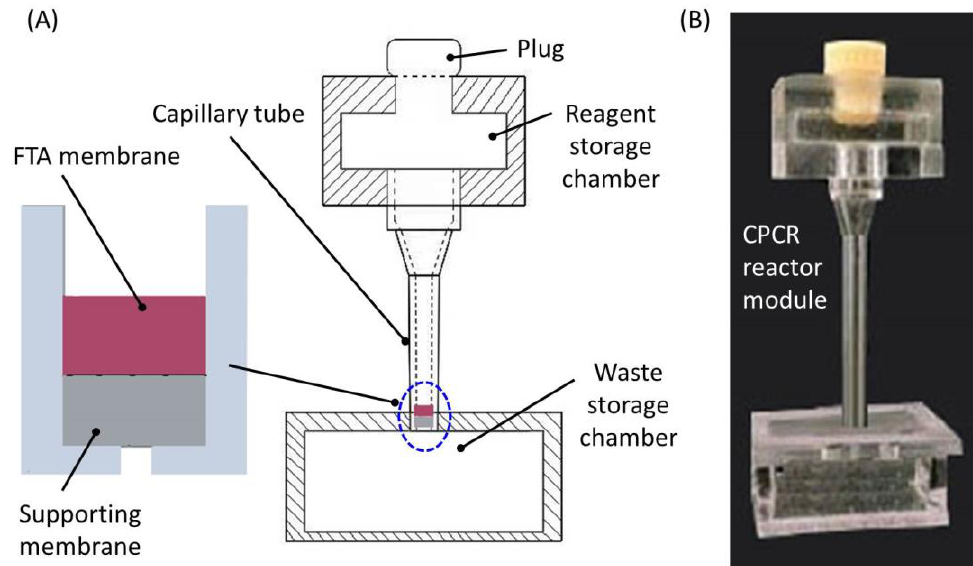
Figure 2. Integrated PCR reactor module. ( A ) Schematic depiction of integrated PCR reactor; ( B ) a photograph of the CPCR reactor module made from PMMA.